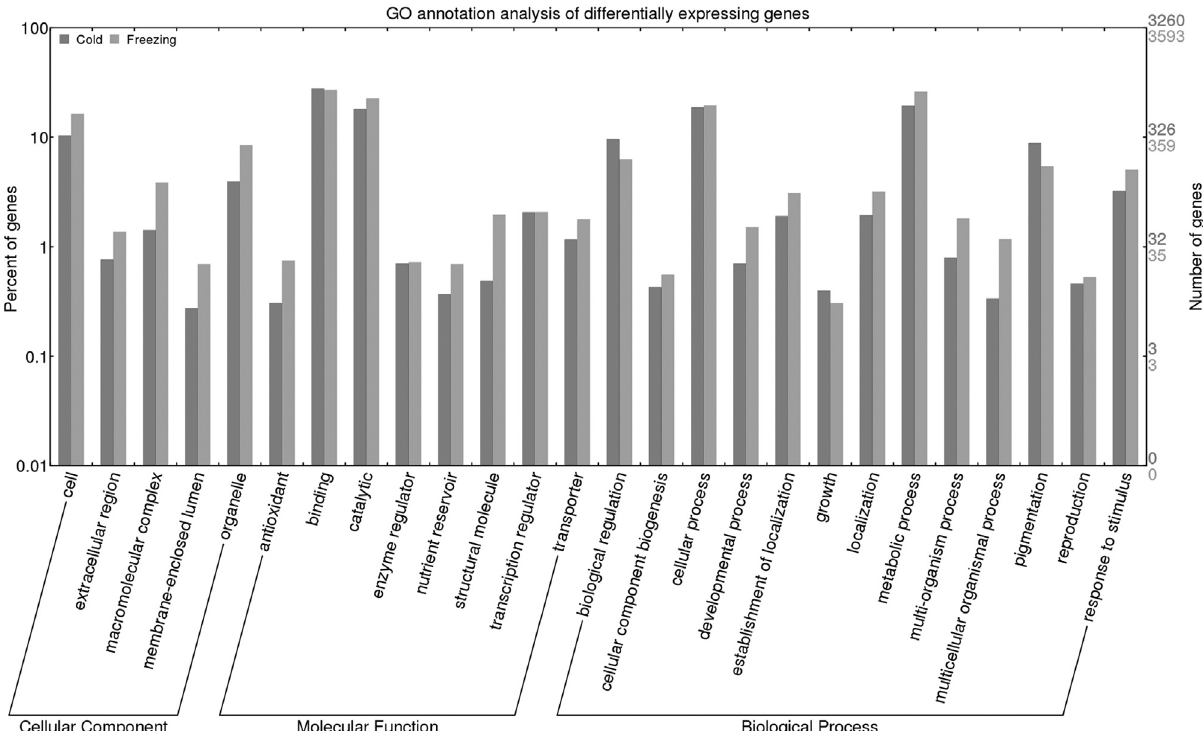
Figure 5 - GO annotation results of alfalfa unique transcripts.